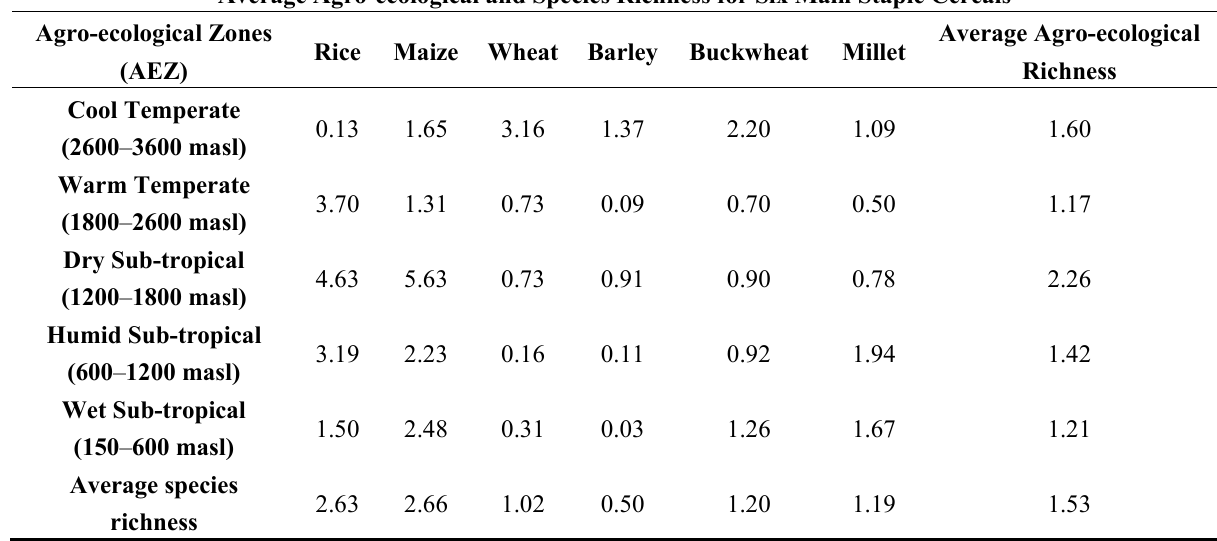
Table 4. Average agro-ecological and species richness for six main staples, 2013. Average Agro-ecological and Species Richness for Six Main Staple